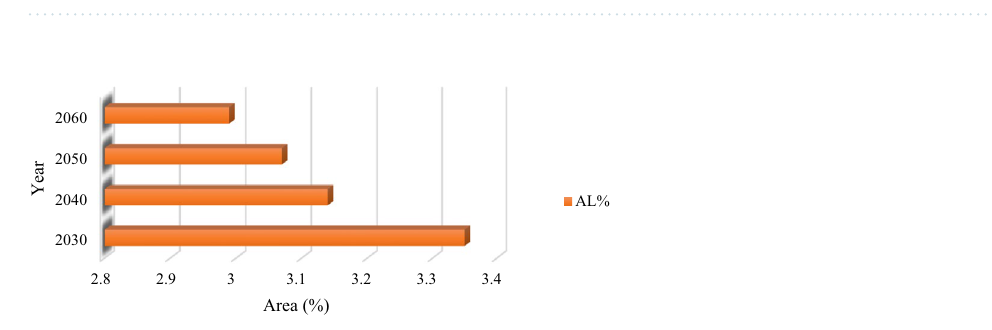
Figure 6. Results of the DL-CNN agricultural land classification method for AL extraction from 2002 to 2021, generated in the ArcGIS 10.6 software (www. esri. com).